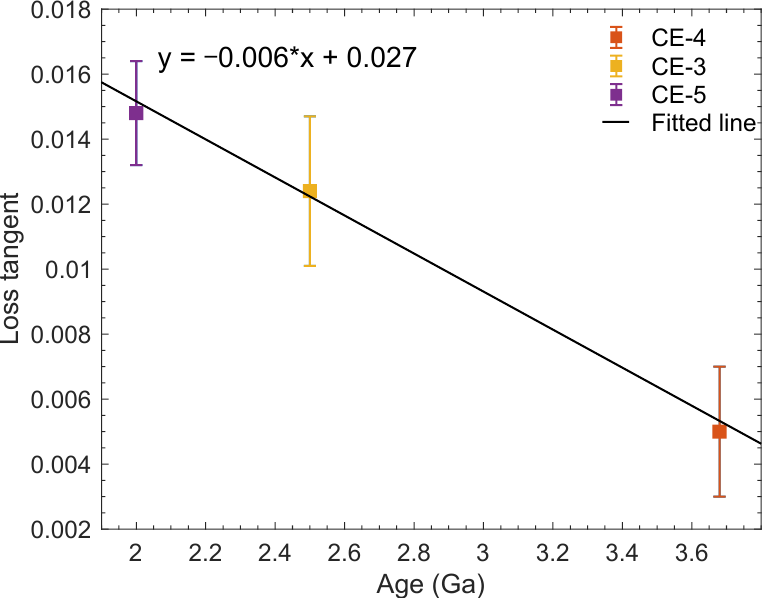
Figure 7. The relationship between the Moon’s surface age and the loss tangents obtained by the Chang’E-3 (Ding et al. [22]), Chang’E-4 (Li et al. [8]), and Chang’E-5